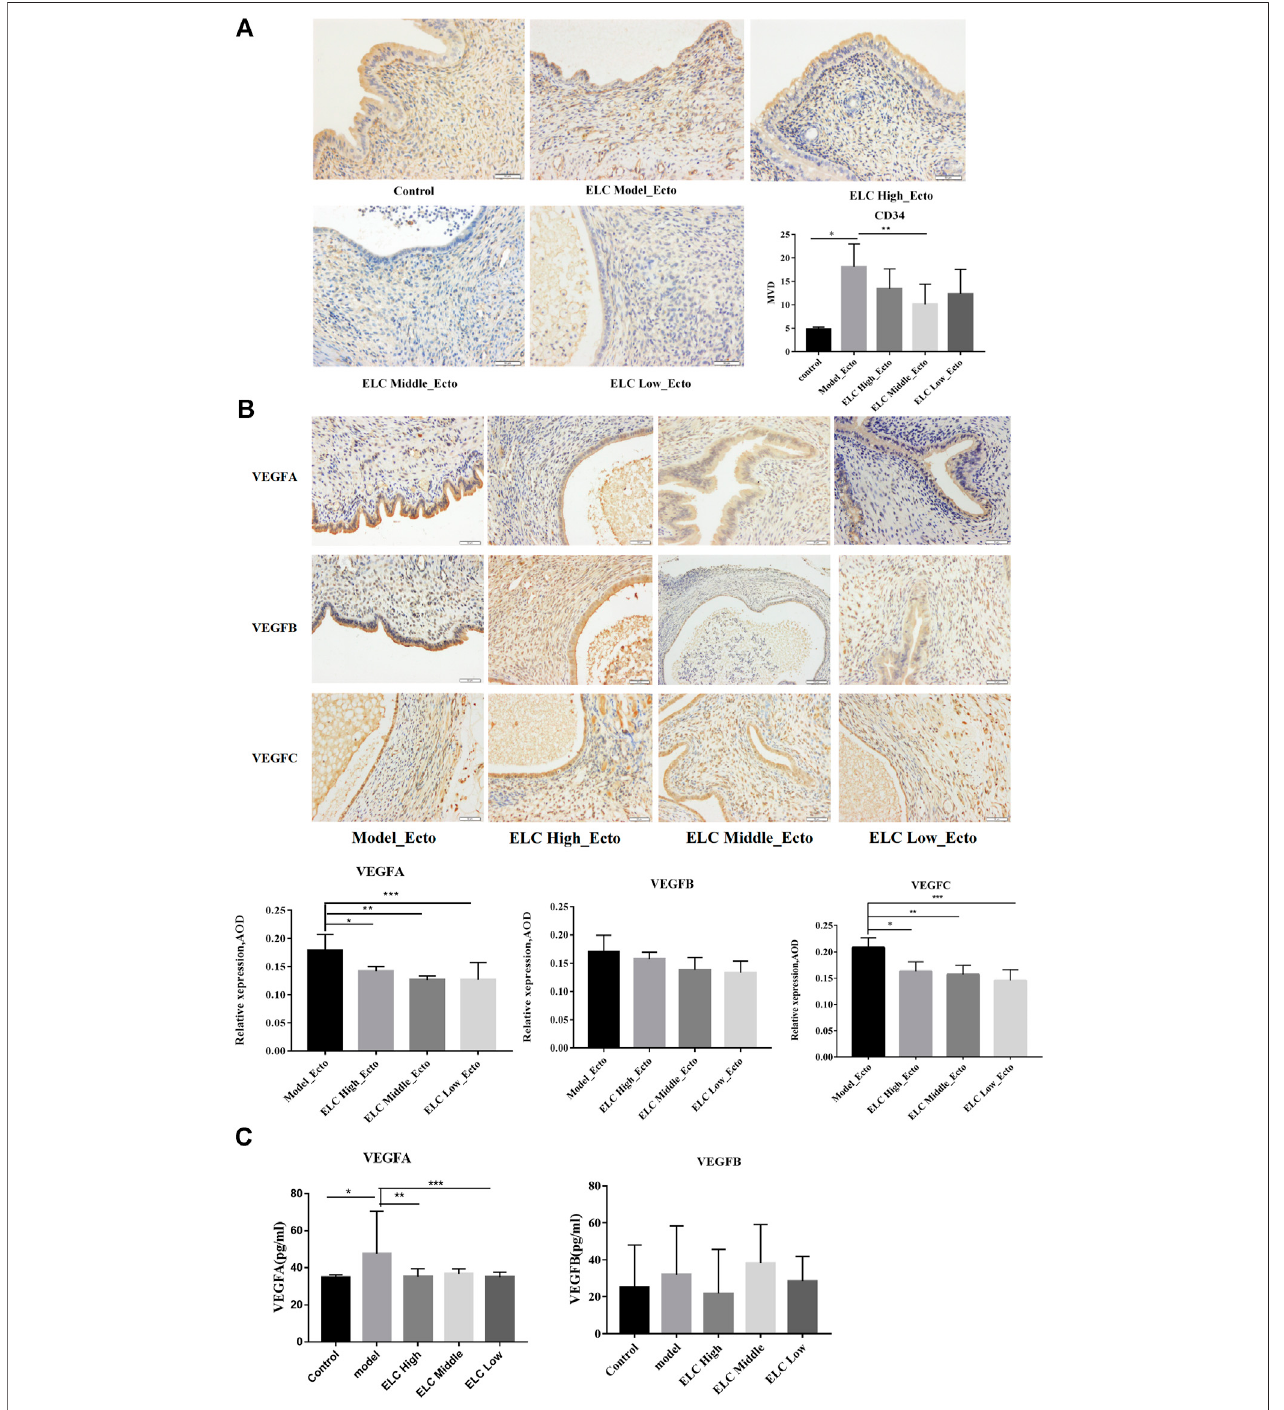
FIGURE4| MVDandexpressionofVEGFinectopicendometrialtissues. (A) Comparedwiththatinthecontrolgroupeutopicendometrium,theMVDintheectopic endometrium in the model group increased ( n (cid:2) 6, * p (cid:2) 0.001 < 0.05). Compared with that in the model group, the MVD in the ectopic endometrium in the ELC middle- dose group decreased (** p (cid:2) 0.018 < 0.05). (B) The results suggested that the expression of VEGFA was statistically signi fi cant ( p (cid:2) 0.014). * p (cid:2) 0.031 < 0.05; ** p (cid:2) 0.004 < 0.05; *** p (cid:2) 0.005 < 0.05. There was no signi fi cant difference in VEGFB expression among different groups ( p > 0.05). Compared with that in the model group, the expression of VEGFC was reduced in ELC groups. * p (cid:2) 0.005; ** p (cid:2) 0.002; *** p (cid:2) 0.000. (C) The expression levels of VEGFA in serum were statistically signi fi cant ( F (cid:2) 2.742, p (cid:2) 0.044 < 0.05). * p (cid:2) 0.008; ** p (cid:2) 0.020; *** p (cid:2) 0.012. There was no signi fi cant difference in the expression levels of VEGFB in serum among different groups ( F (cid:2) 0.674, p (cid:2) 0.614 > 0.05). Values are represented as mean ± SD, n (cid:2) 4. p < 0.05 as determined by one-way ANOVA.